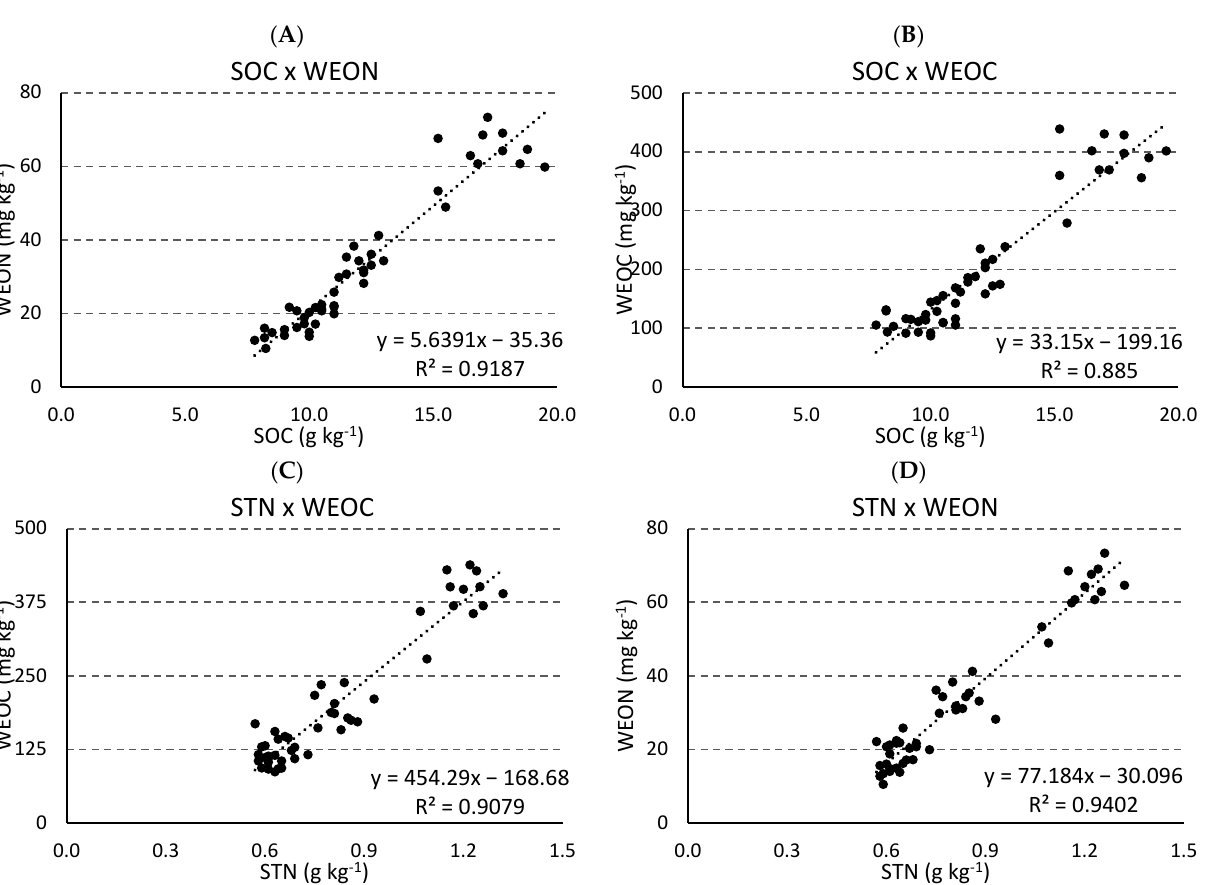
Figure 1. Linear relationship between soil organic carbon and water extractable organic carbon ( A ); soil organic carbon and water extractable organic nitrogen ( B ); soil total nitrogen and water extractable organic carbon ( C ); and soil total nitrogen and water extractable organic nitrogen ( D ). Equations and coefficients of determination are displayed in each graph.